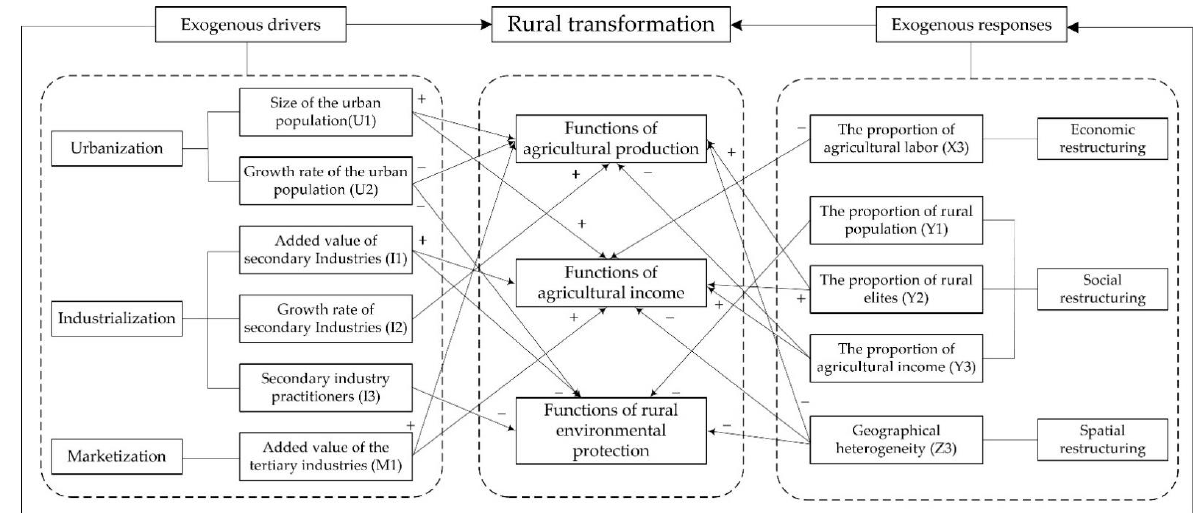
Figure 5. Mechanism of rural transformation in Jianghan Plain.